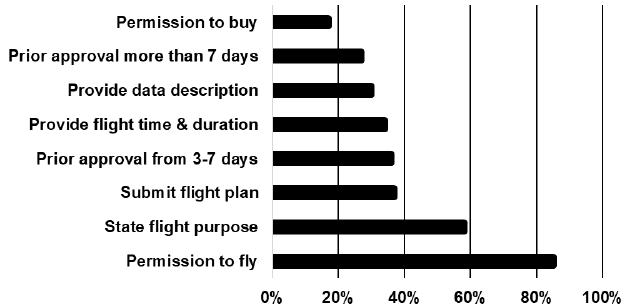
Figure 1. Institutions’ additional self-imposed restrictions in UAV policies beyond FAA rules and regulations (N=198).